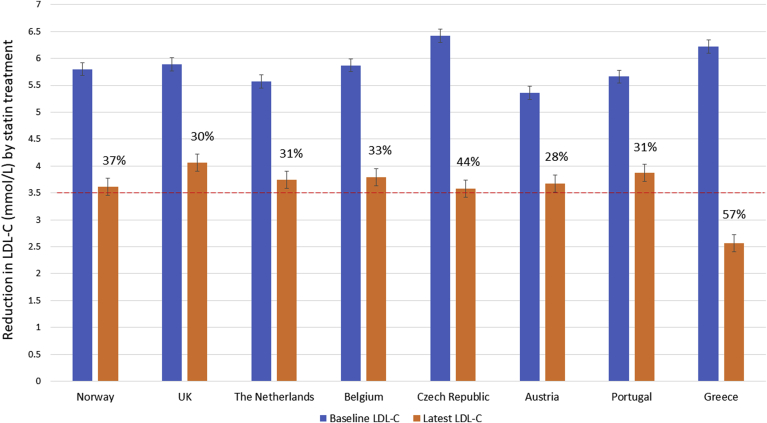
Baseline and treated LDL-C in children who went on receiving statins.The percentage on top of latest LDL-C bars represent the reduction in LDL-C by treatment in each cohort.